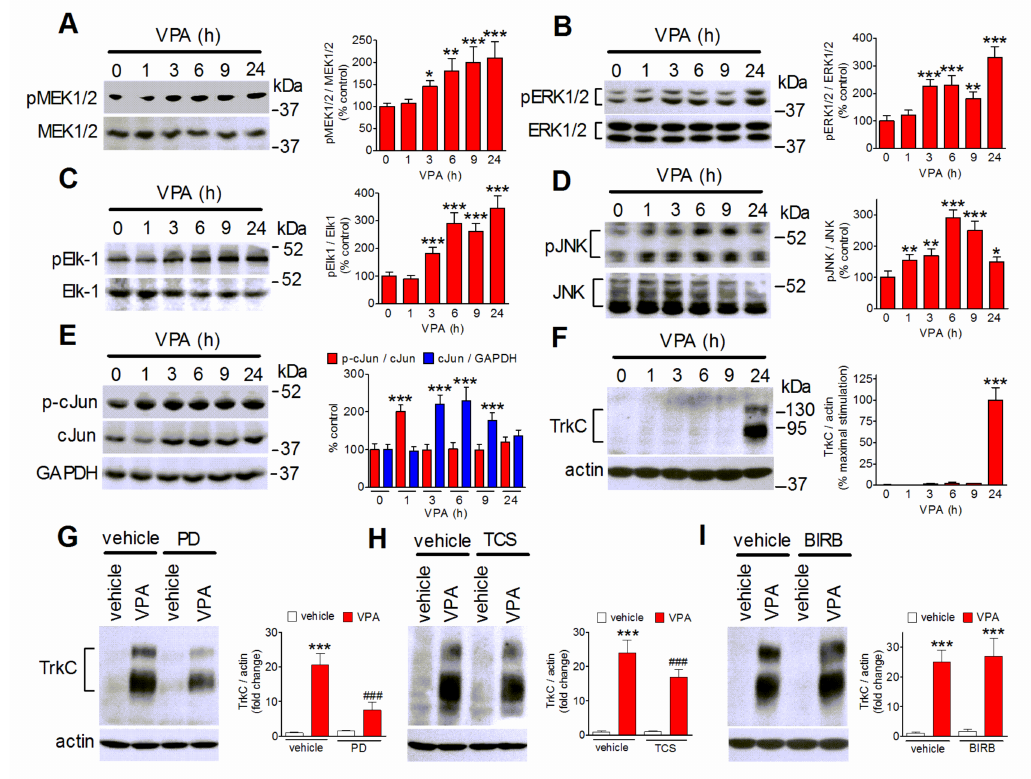
Figure 5. Participation of ERK1/2 and JNK in VPA-induced TrkC upregulation. ( A – F ) SH-SY5Y cells were incubated in serum-free medium with 1 mM VPA for the indicated periods of time. Zero time samples were treated with vehicle and used as control. Cell lysates were analyzed for phospho-MEK1/2 (pMEK1/2), MEK1/2 ( A ), phospho-ERK1/2, ERK1/2 ( B ), phospho-Ser383-Elk-1 (pElk-1), Elk-1 ( C ), phospho-JNK (pJNK), JNK ( D ), phospho-Ser73-cJun (p-cJun), cJun, GAPDH ( E ), TrkC and actin ( F ). Values are the mean ± SD of four independent experiments. * p < 0.05, ** p < 0.01, *** p < 0.001 vs. control. ( G – I ) SH-SY5Y cells were preincubated for 1 h with either vehicle, 25 µ M PD 98,059 (PD) ( G ), 10 µ M TCS JNK6o (TCS) ( H ), or 1 µ M BIRB 0796 (BIRB) ( I ) and then exposed to either vehicle or 1 mM VPA for 24 h. Cell lysates were analyzed for TrkC expression. Values are the mean ± SD of four experiments. *** p < 0.001 vs. control (vehicle + vehicle); ### p < 0.001 vs. vehicle + VPA by ANOVA followed by Tukey’s